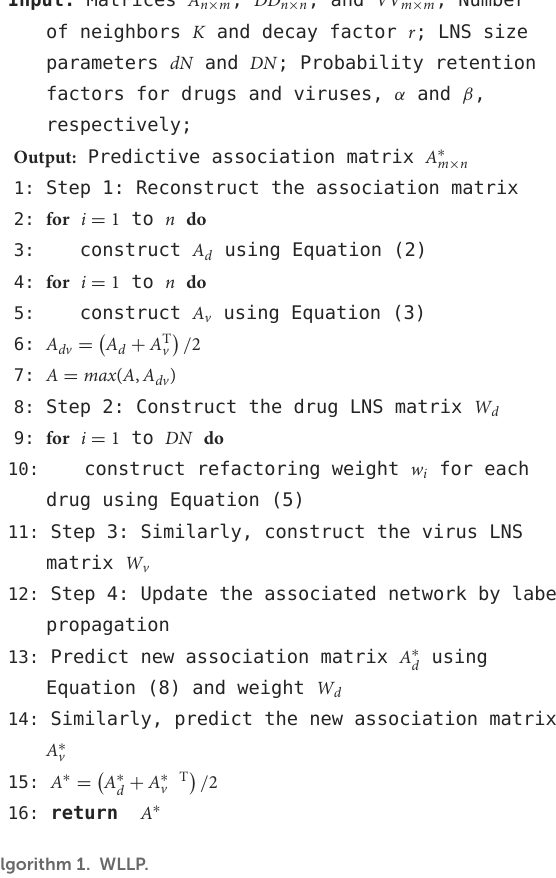
algorithm to preprocess the original association matrix (Ezzat